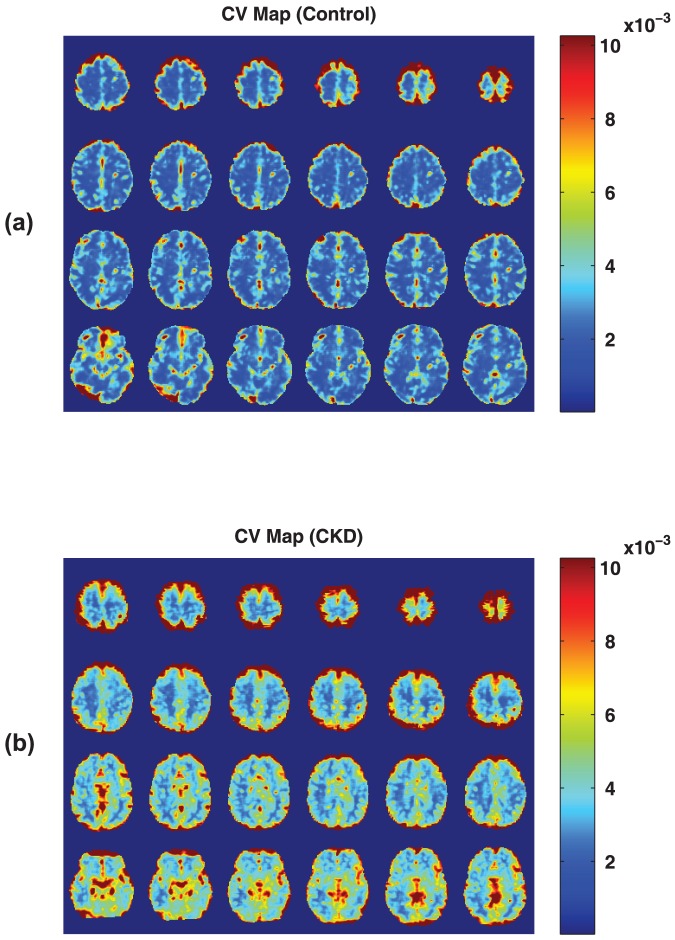
Coefficient of variation (CV) maps calculated for a representative (a) CKD patient and (b) young healthy control.No temporal filtration was applied.